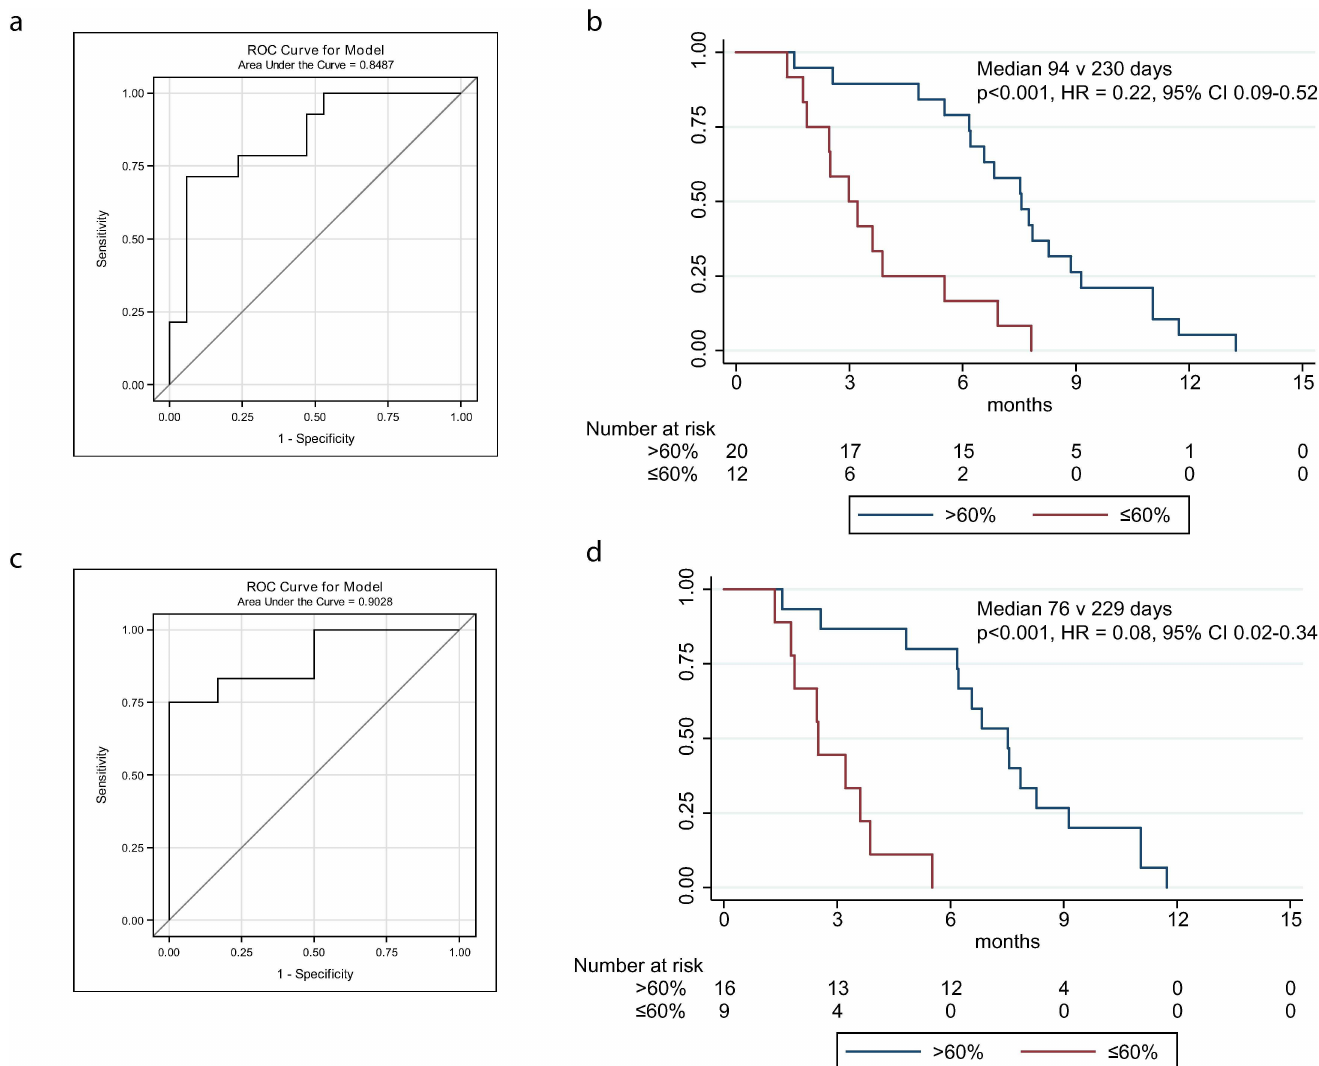
Fig 4. ROC curves and Kaplan-Meier plots for change in circulating tumour DNA after one cycle of chemotherapy, including and excluding courses with recent ascitic drains. (A) ROC plot identifies60% decreasein TP53MAF as the most accurate thresholdfor predicting 6-mo TTP in all patients. (B) Kaplan-Meier curve showingTTP for patients with decreaseof (cid:20) 60% or > 60% after one cycle of chemotherapy. (C) ROC plot identifies a 60% decreasein TP53MAF as the most accurate threshold for predicting6-mo TTP in patients without ascitic drains. (D) Kaplan-Meier curve for TP53MAF decreaseafter one cycle of chemotherapy to predict 6-mo progression-free survival in patients without ascitic drains. ctDNA, circulating tumour DNA; HR, hazard ratio; ROC, receiver operatingcharacteristic; TP53MAF, TP53 mutant allelefraction; TTP, time to